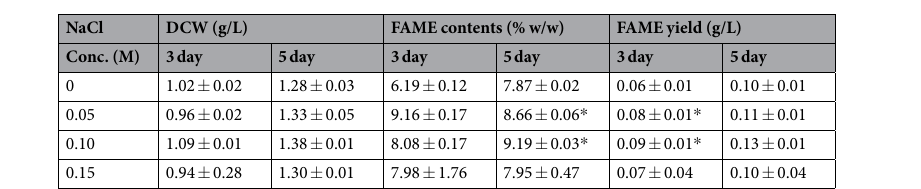
Table 1. Total dry cell weight, lipid contents, and lipid yields of C . reinhardtii under various levels of osmotic stress. Data are expressed as mean ± SD ( n = 3). Significant differences, as determined by Student’s t-test, are indicated by an asterisk ( * P < 0.05, ** P < 0.01, *** P <